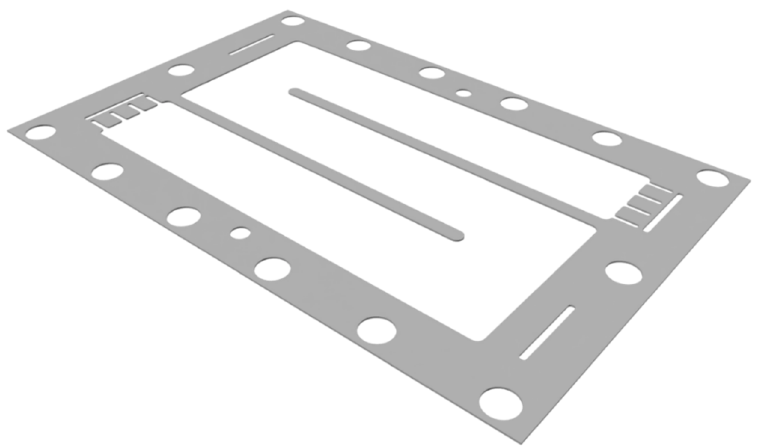
Figure 3. The image of the gaskets of the “labyrinth” shape for the dialysis module.